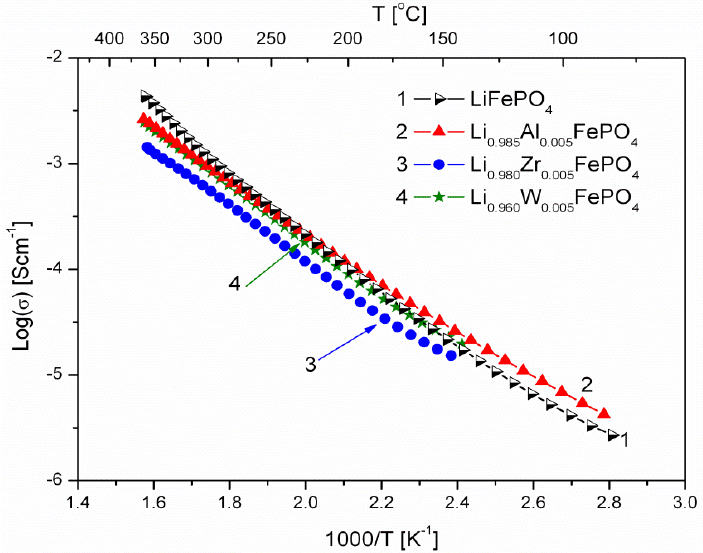
Figure 7. Temperature dependence of electrical conductivity of Li-site substituted phosphoolivines with x = 0.005 mol mol − 1